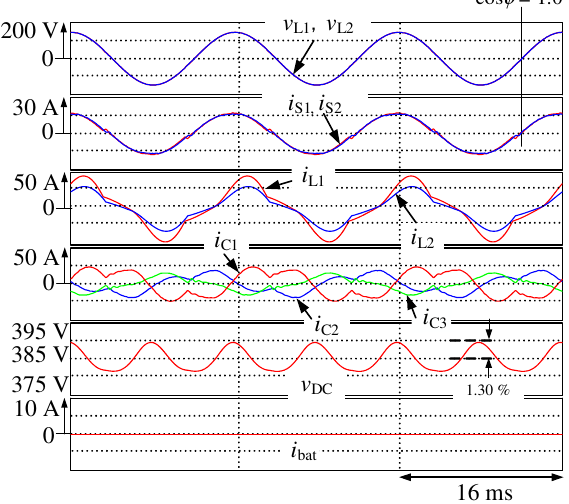
Figure 9. Simulation results for Figure 4 without battery, where smart charger performs active power-line